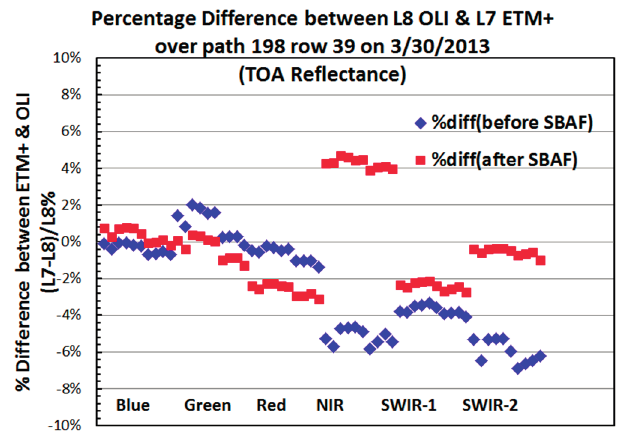
Figure 6. Cross calibration scenes based on path 198, row